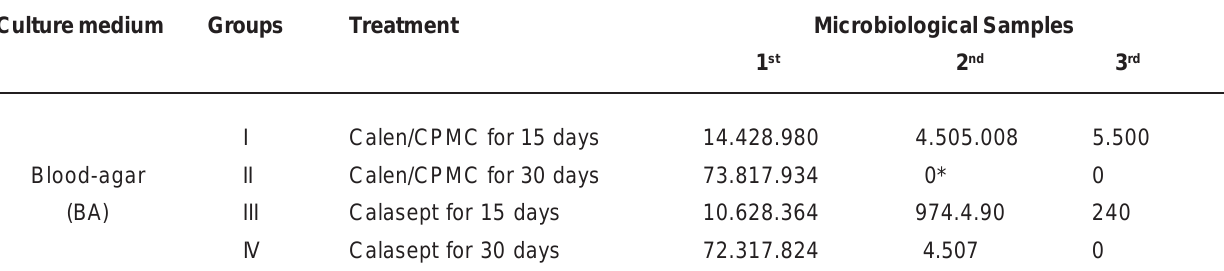
the four experimental